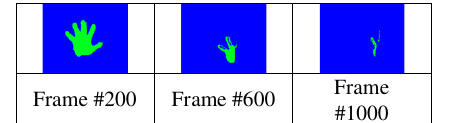
Figure 9: Examples of tracked hand segments as the speed gets